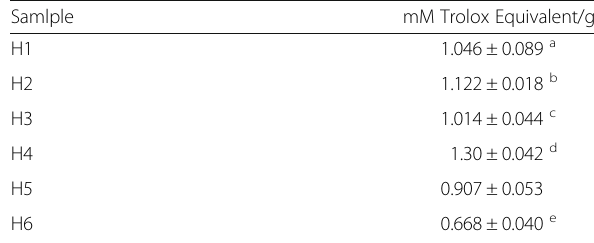
Table 2 Anti-hemolytic effect of honey varieties (mM Trolox